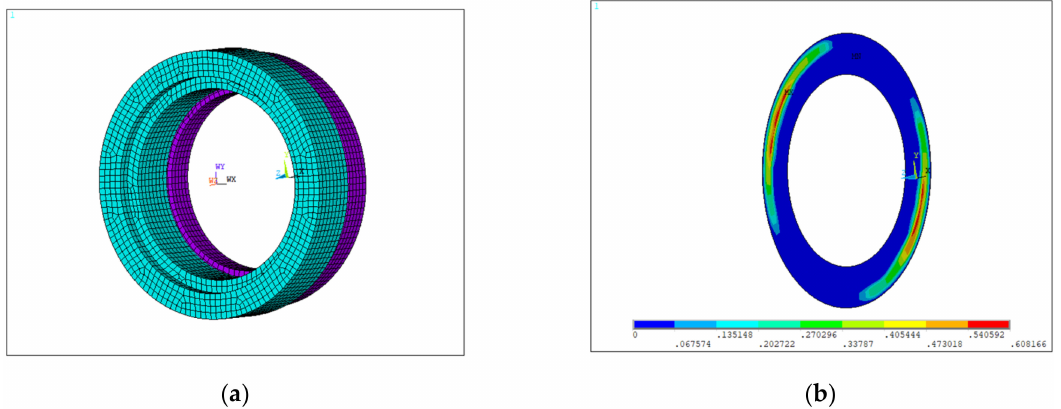
Figure 9. The graphite ring model in an oblique view: ( a ) finite element model; ( b ) simulation results of contact stresses.